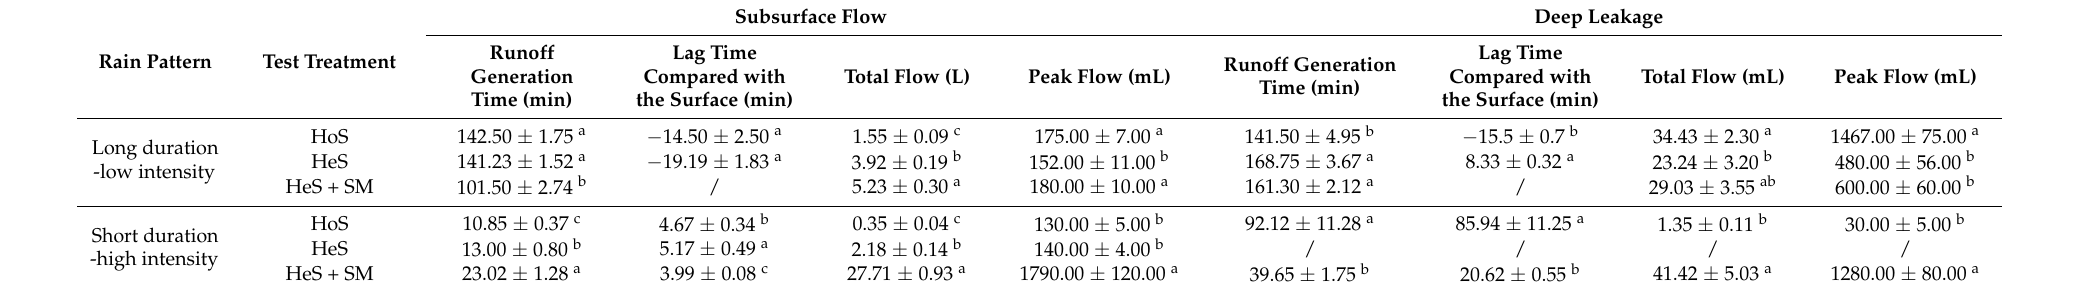
Table 5. Effects of straw mulching on subsurface flow and deep leakage in red soil sloping